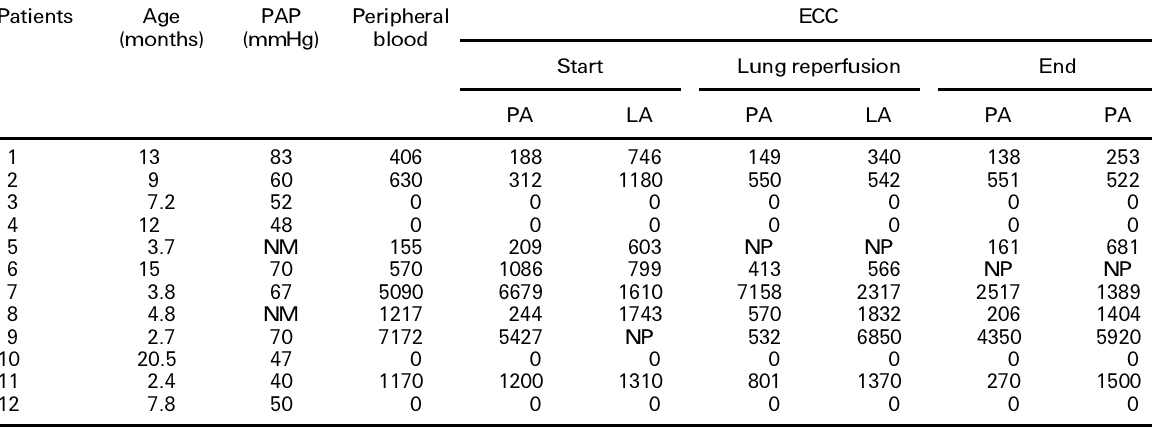
PA = pulmonary artery; LA = left atrium; 0 = below level of assay detection; NP = no sample; ECC = extracorporeal circulation; NM = not measured; PAP = pulmonary arterial pressure (prior to surgery); months = age at surgery.